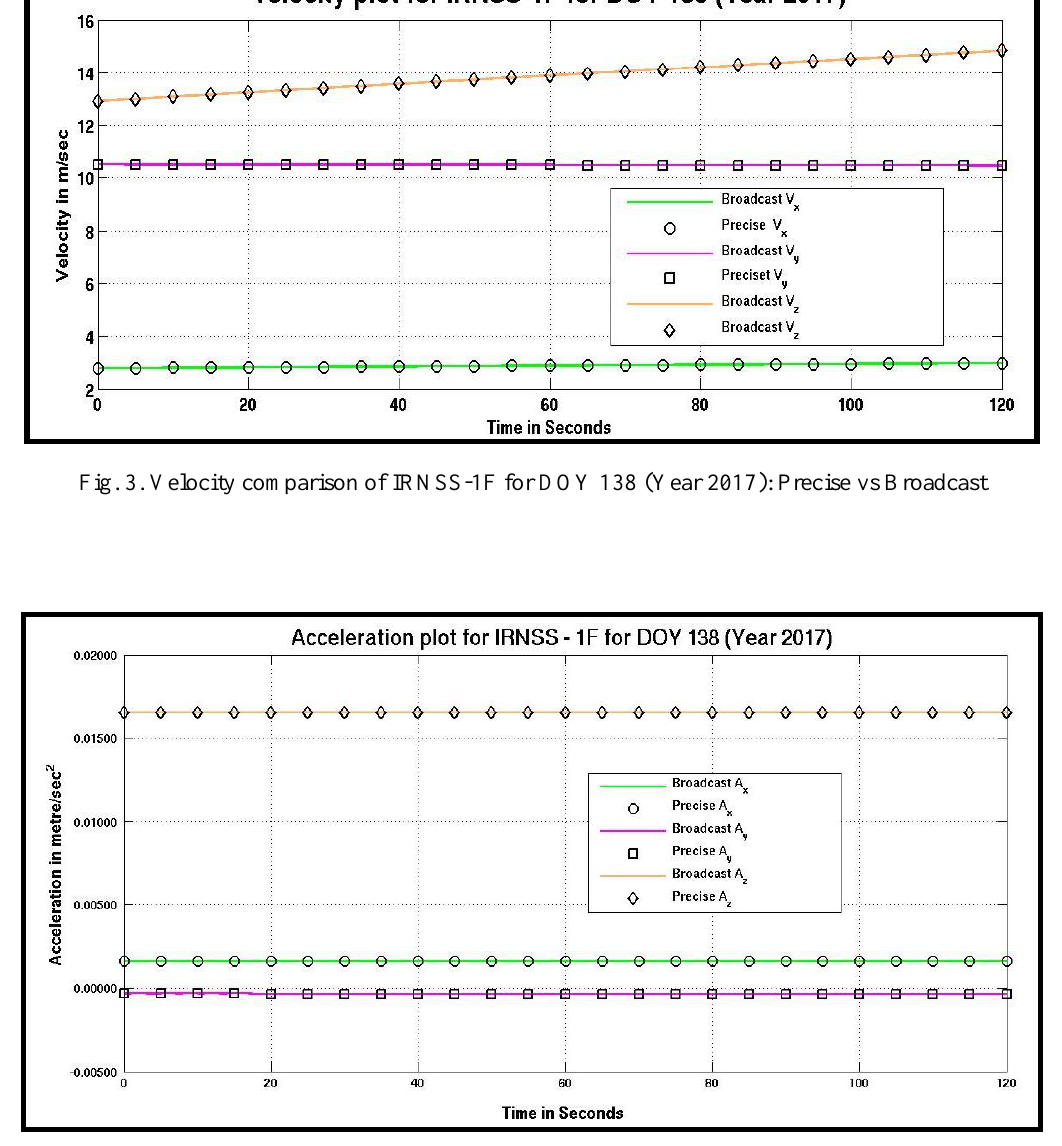
Fig. 4. Acceleration comparison of IRNSS-1F for DOY 138 (Year 2017): Precise vs